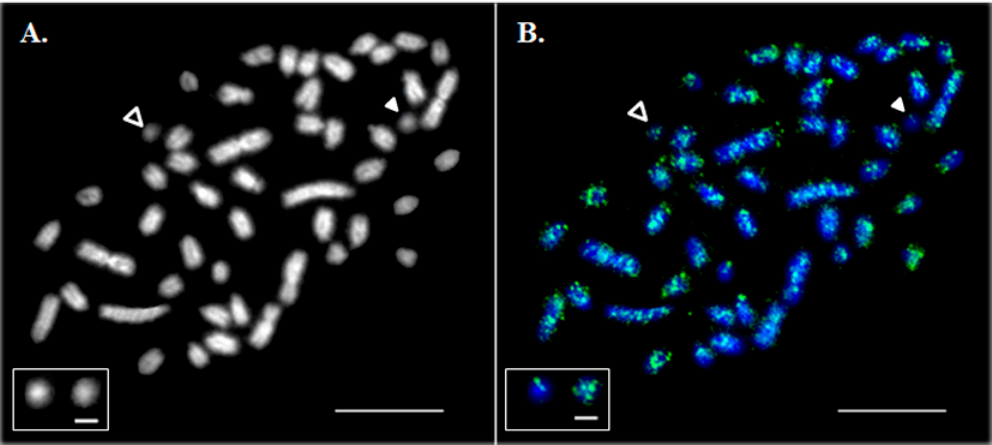
Figure 1. Hybridization of mixed Cot-1 DNA from liver, ovary and testis on metaphase chromosomes. ( A ) A DAPI-stained metaphase spread. ( B ) Asian seabass Cot-1 DNA fraction hybridization (green). Chromosomes were contrasted by 4 ′ ,6-diamidino-2-phenylindole (DAPI; blue). Empty arrowheads indicate B chromosomes (Bchrs). White arrowheads indicate Bchrs with a low level of Cot-1 signal. The bar is 5 μ m. The inset shows magnified examples of Bchrs with a low (left) and high (right) intensity of Cot-1 signal; the bar for the framed B chromosomes is 1 μ m.